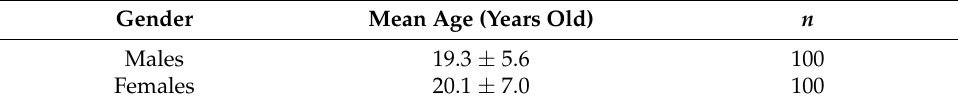
Table 1. Demographic profile of this study.